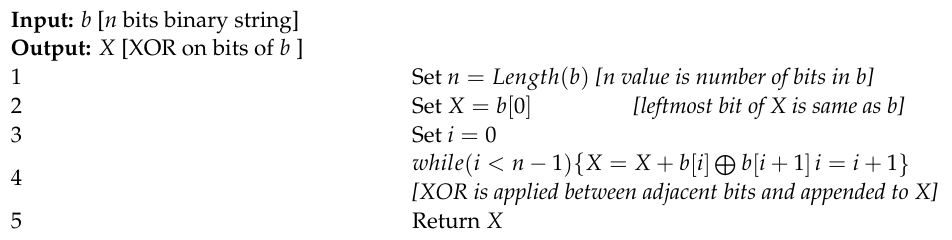
Algorithm 1: Processing binary string with XOR to obtain new XORed string